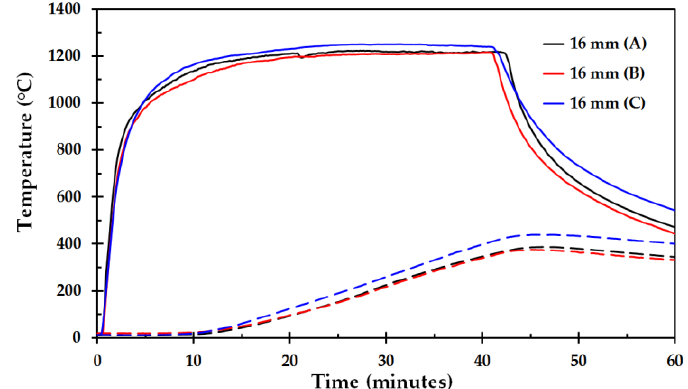
Figure 8. Temperature as a function of time for 16 mm thick steel plate, test A, B and C. Solid lines